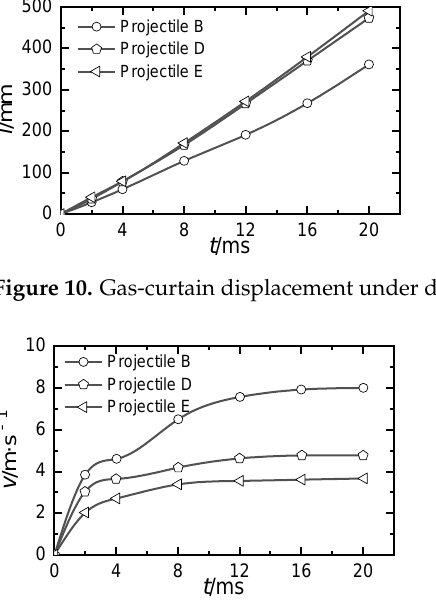
Figure 11. Projectile velocity under different groove numbers.